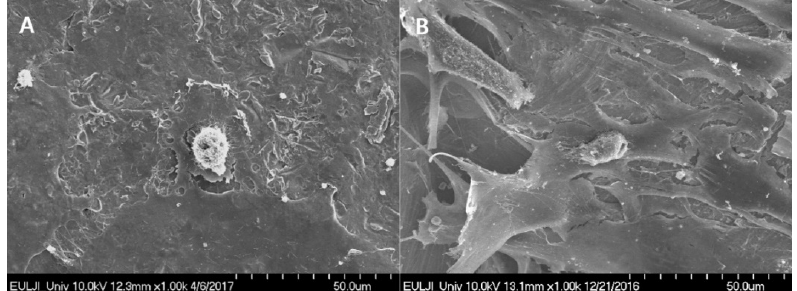
Figure 3. SEM images of osteoblast after 6 h of incubation on ( A ) SUS-machined specimens (×1000) and ( B ) SUS-DMF specimens (×1000). ( A ) The surface of the SUS-machined specimens was covered with sparse, small osteoblast cells. ( B ) The surface of the DMF specimens was firmly covered with large, healthy lamellipodia of osteoblast cells. Branches of thin cytoplasmic process from filopodia were seen entering the pores.